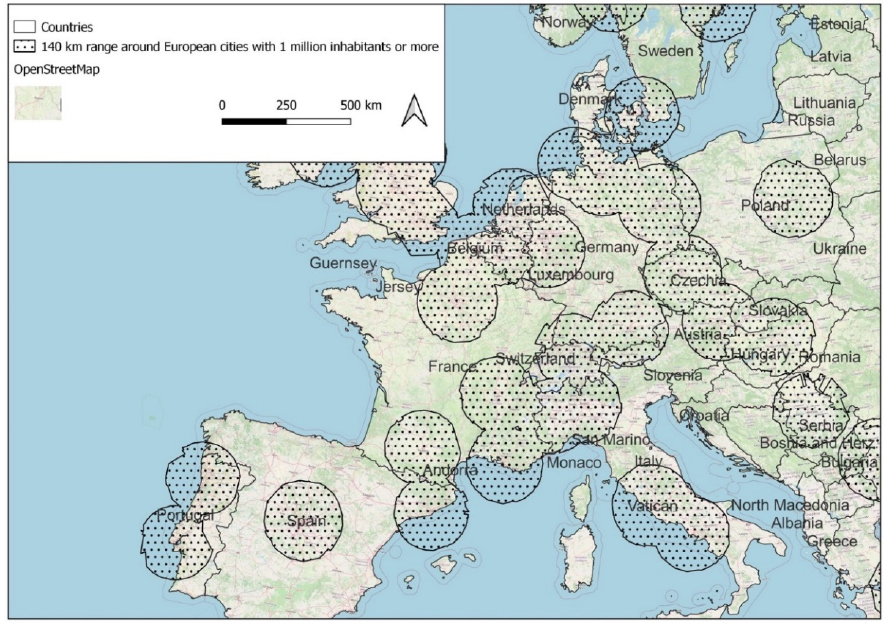
Figure 1. Map of central Europe experiencing a hypothetical nuclear attack with 150-kiloton warheads on cities with populations over 1 million.